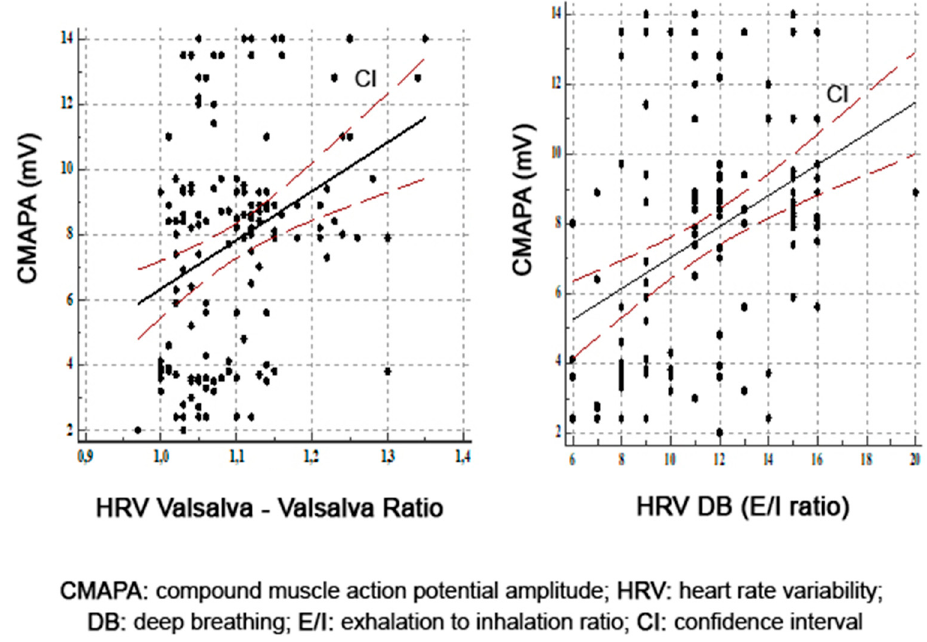
Figure 3. Correlations between amplitude of motor response in tibial nerves and HRV Valsalva and HRV DB.